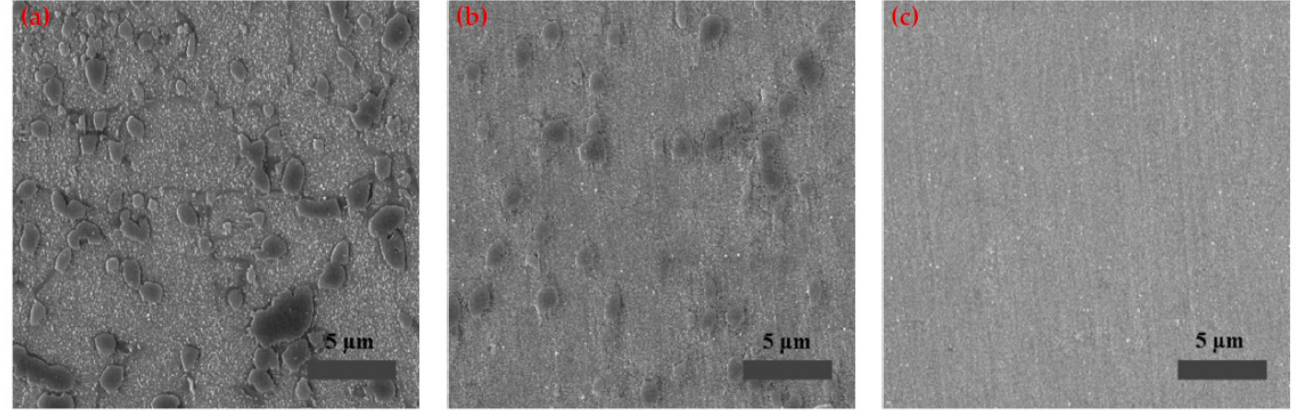
Figure 4. Morphology of the γ′ phase near the GH4065A joints. ( a ) PDMZ, ( b ) TMAZ, ( c )